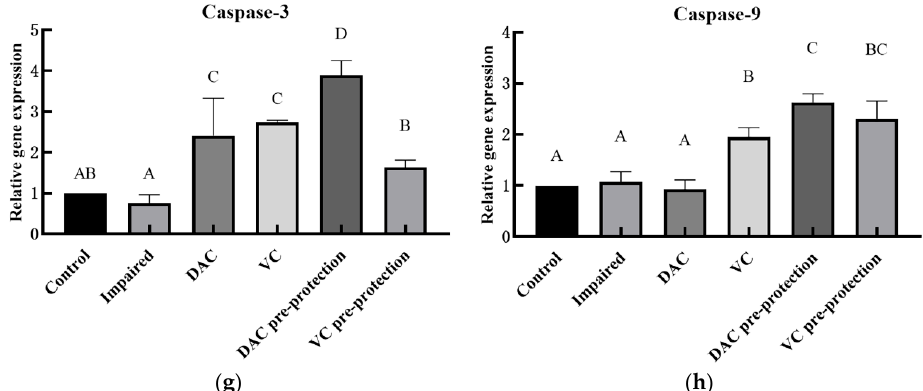
Figure 3. Effect of DAC pre-protection on mRNA relative expression of key genes in Nrf2 and MAPK-JNK signaling pathway in GMEC. Key genes in the Nrf2 pathway for antioxidant function include ( a ) Nrf2, ( b ) HO-1, and ( c ) NQO-1. Major inflammatory factors include: ( d ) IL-1 β and ( e ) TNF- α . Key genes in the MAPK-JNK pathway for apoptosis include: ( f ) Bax/Bcl-2, ( g ) Caspase-3, and ( h ) Caspase-9.